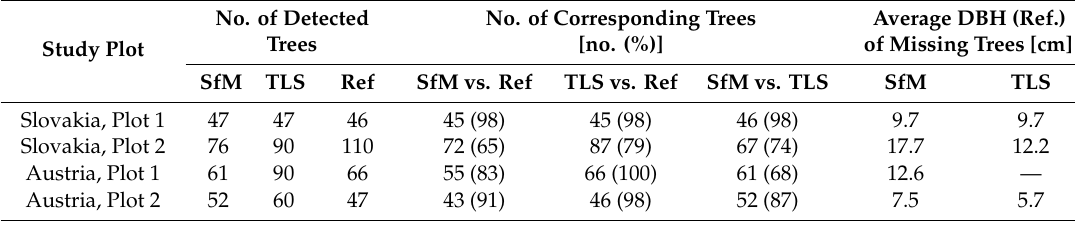
Figure 5. Tree locations and corresponding DBHs for each forest plot. Reference DBHs are shown as black circles of respective diameters, centred at their reference positions. Trees identified by TLS are shown in blue, and those detected by SfM in turquoise. The circles of reference DBHs identified neither by TLS, nor by SfM are filled with red. The dashed lines indicate the plot boundaries. Table 4. Completeness of tree stem detection.